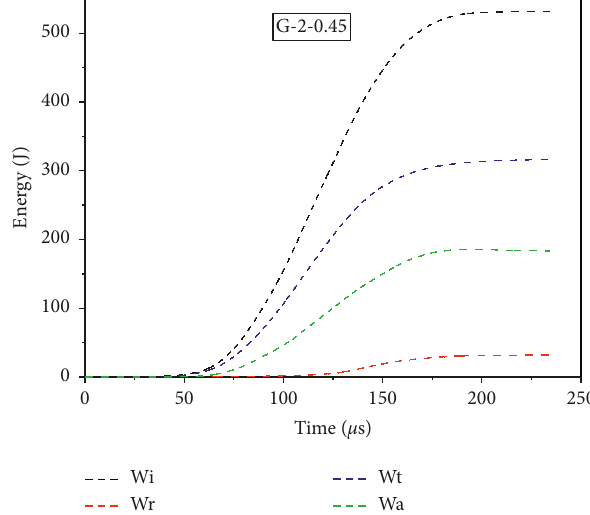
Figure 4: Dynamic stresses on both ends of the granite specimen. Figure